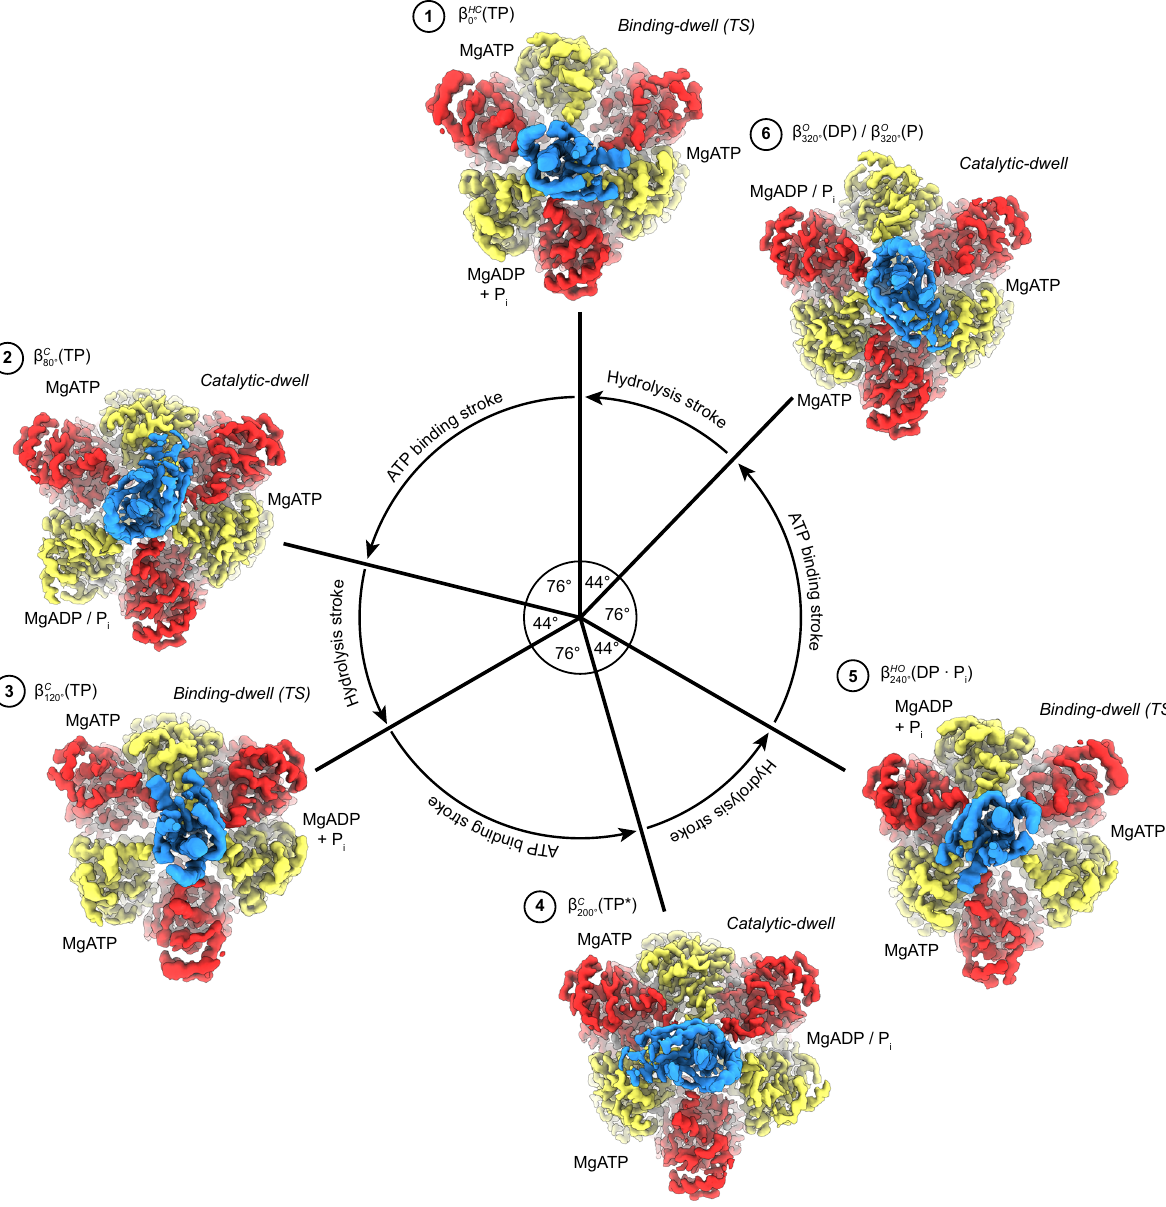
Fig. 6 The reaction scheme of Bacillus PS3 F 1 -ATPase suggested by cryo-EM. Similar to Fig. 1b, the circle with arrows describes rotation of the γ -subunit. Cryo-EM maps for each state are shown as surfaces, colored as in Fig. 1a. ATP is sequentially bound and hydrolyzed, causing the ATP-binding stroke (76° rotation) and hydrolysis stroke (44° rotation). Nucleotide-binding sites are labeled 1 → 6 to highlight the reaction path of a single